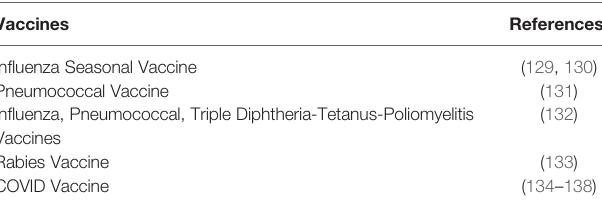
TABLE 3 | Vaccines associated with iTTP.